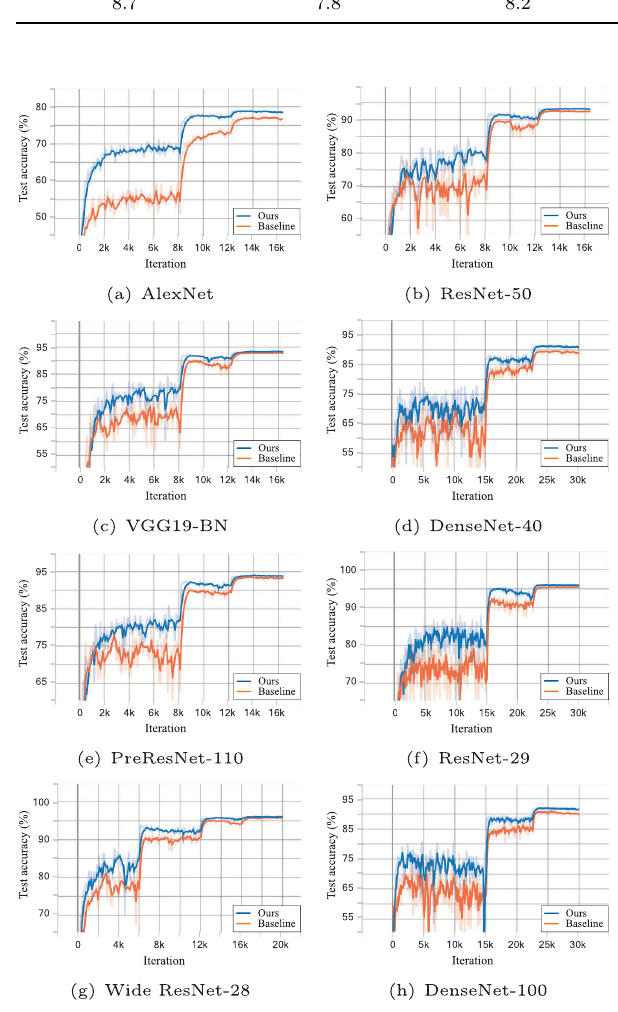
Fig. 4 Test accuracy and convergence speed of our WAU method and a baseline, for various convolutional networks, on